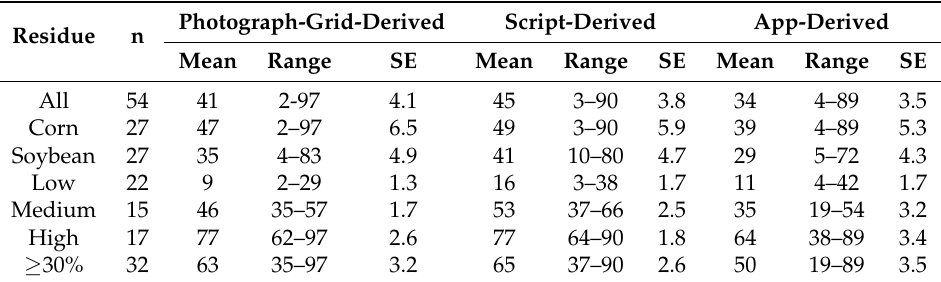
Table 2. Summary statistics for residue cover percent grouped by residue type and